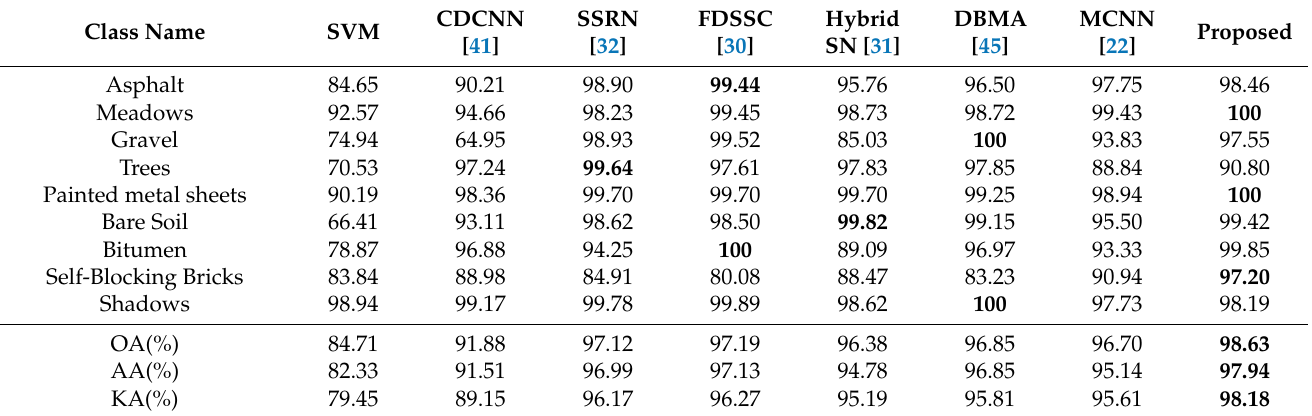
Table 5. Classification results of different models on the PU